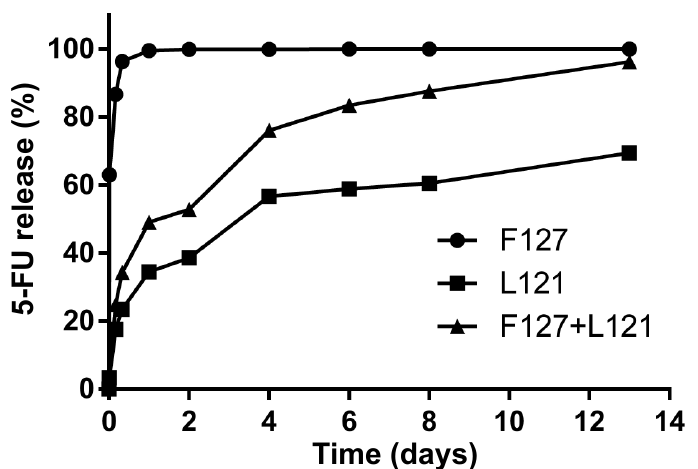
Figure 4. Curves of 5-FU drug release were plotted for F127, L121, and 5-FU/F127/L121 Pluronic blending composites at 37 °C.